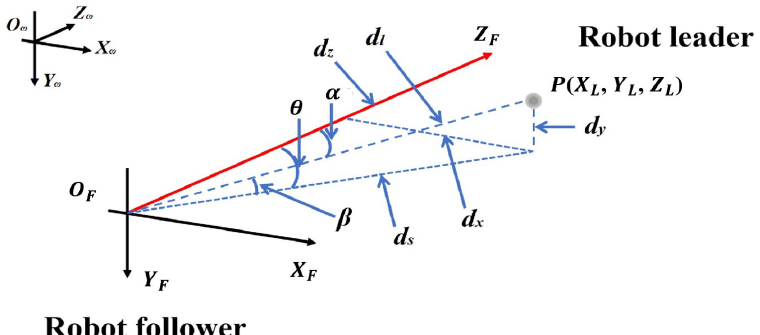
Figure 8. The schematic diagram of visual solution information